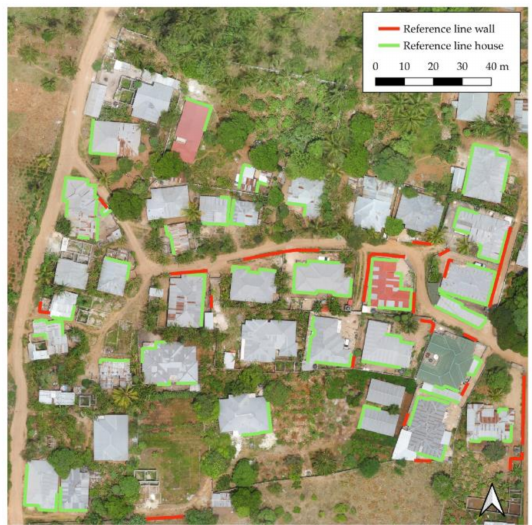
Figure 8. Selected reference lines representing rooftops (green) and walls (red) for the area of interest in